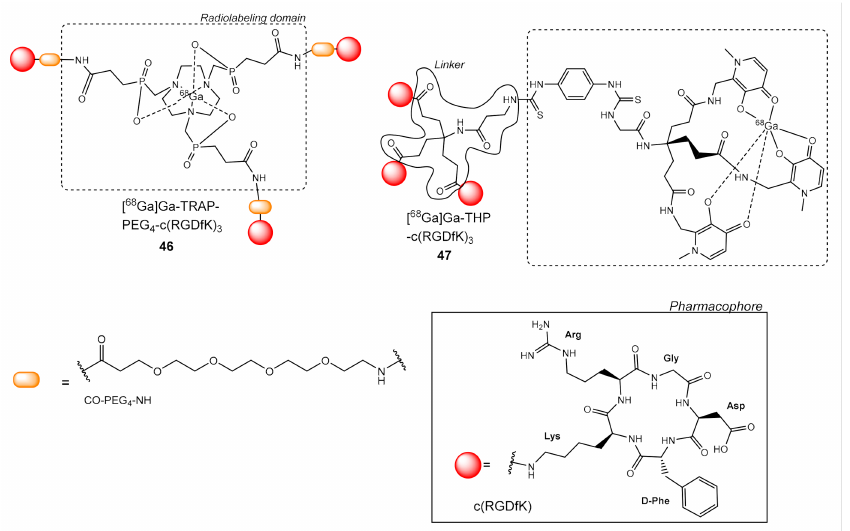
Figure 13. Chemical structures of 68 Ga trimers of c(RGDfK) with TRAP 46 and THP 47 chela- tor